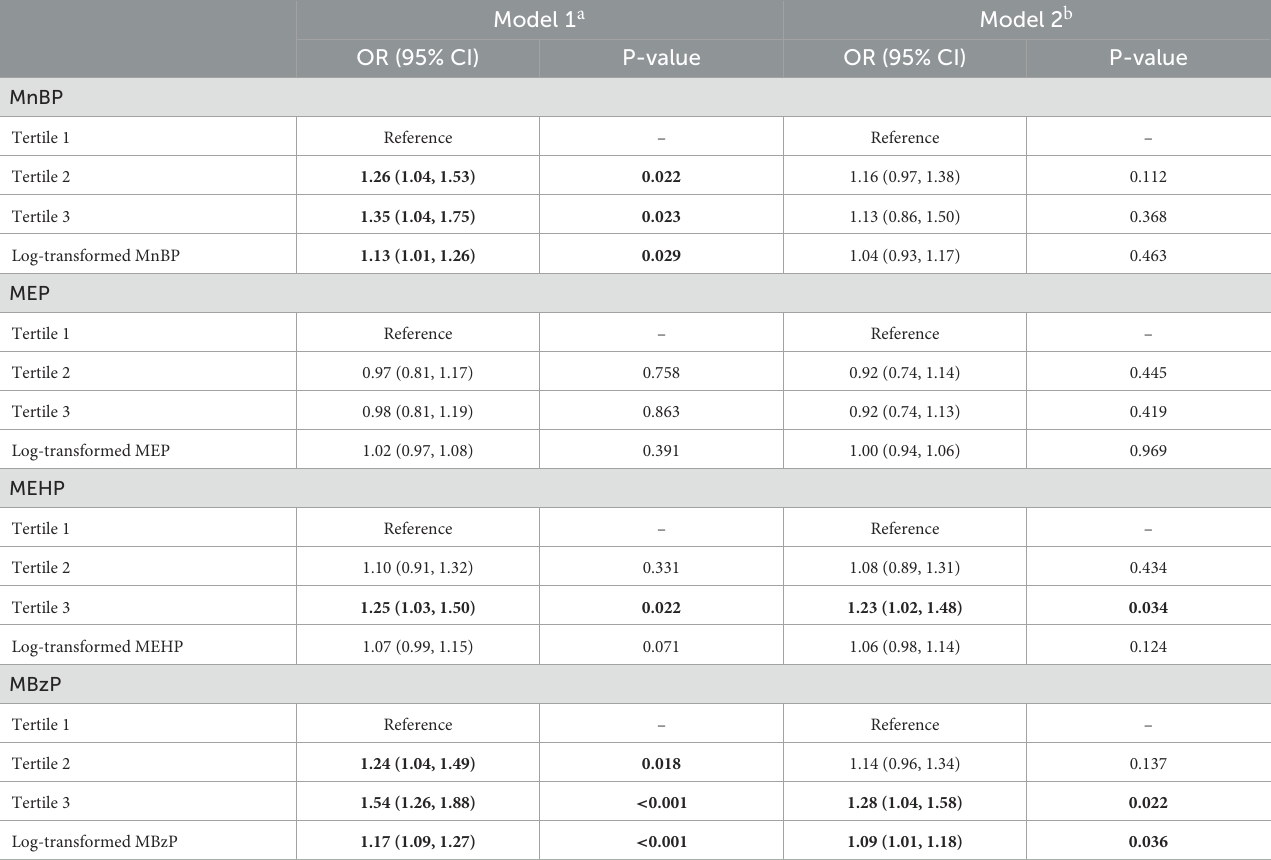
TABLE 3 Association of urinary phthalate metabolites and chronic pain among US adults, NHANES 1999–2004 ( n =